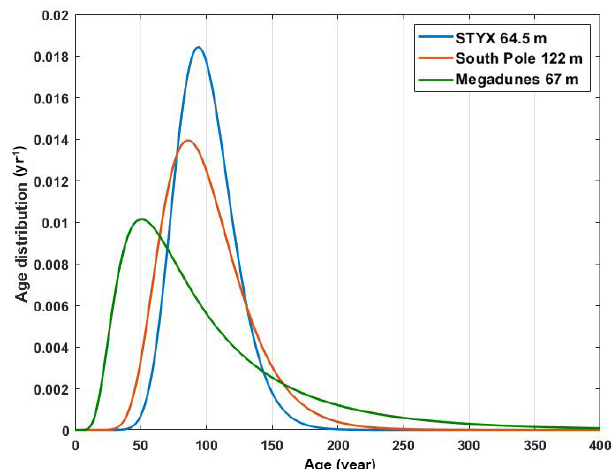
Figure 4. Comparison of model-simulated CO 2 age distributions at Styx (this study), South Pole (Battle et al., 1996), and Megadunes (Severinghaus et al.,